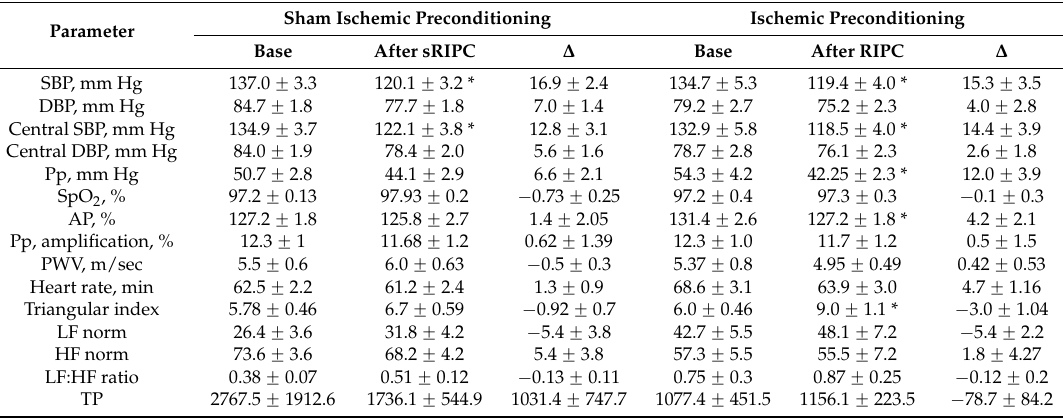
Table 3. Changes in cardiovascular parameters after sRIPC/RIPC in CHD group ( n = 30). Sham Ischemic Preconditioning Ischemic Preconditioning Parameter Base After sRIPC